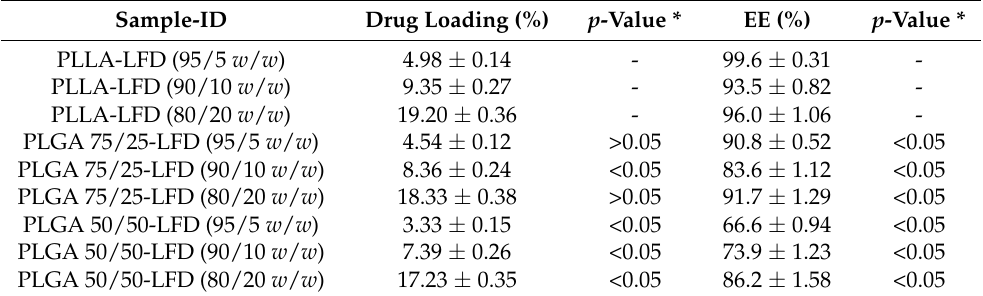
Table 2. Drug loading and EE values of the prepared LFD-loaded polyester patches.